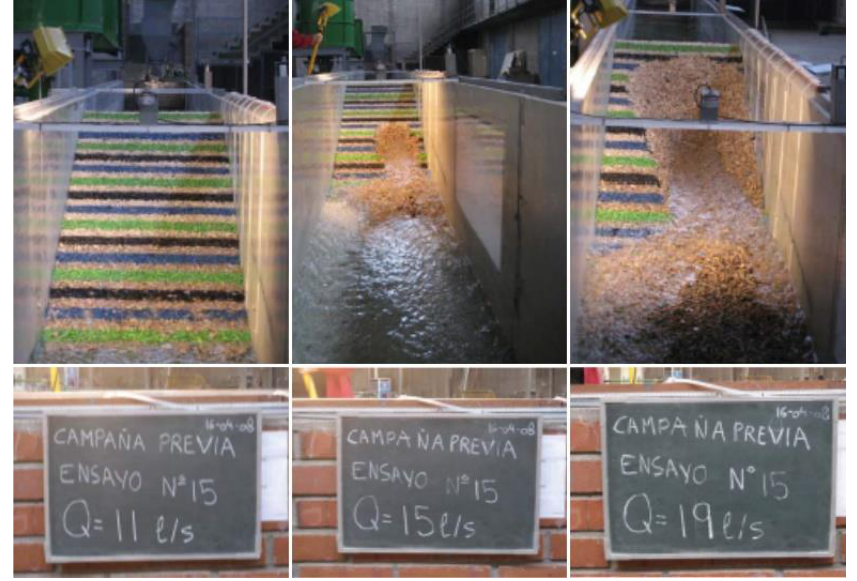
Figure 12. Images of test nº 95 [ 𝑍 dss = 3.0 ] before and during the pressure dropdown (Figure 11).